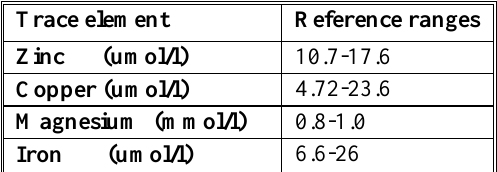
Table (1): The reference range for the trace elements